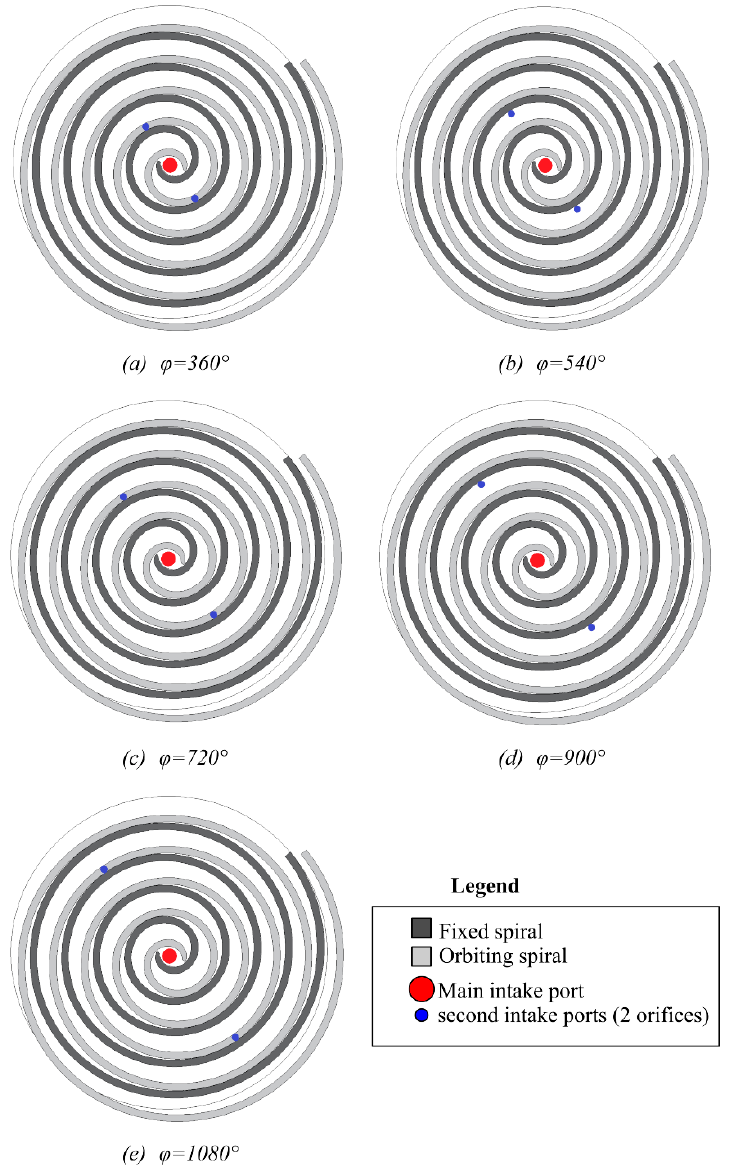
Figure 10. Position of second intake ports as the function of angular delay φ with respect to the main intake port: φ = 360° ( a ), φ = 540° ( b ), φ = 720° ( c ), φ = 900° ( d ) and φ = 1080° ( e ).